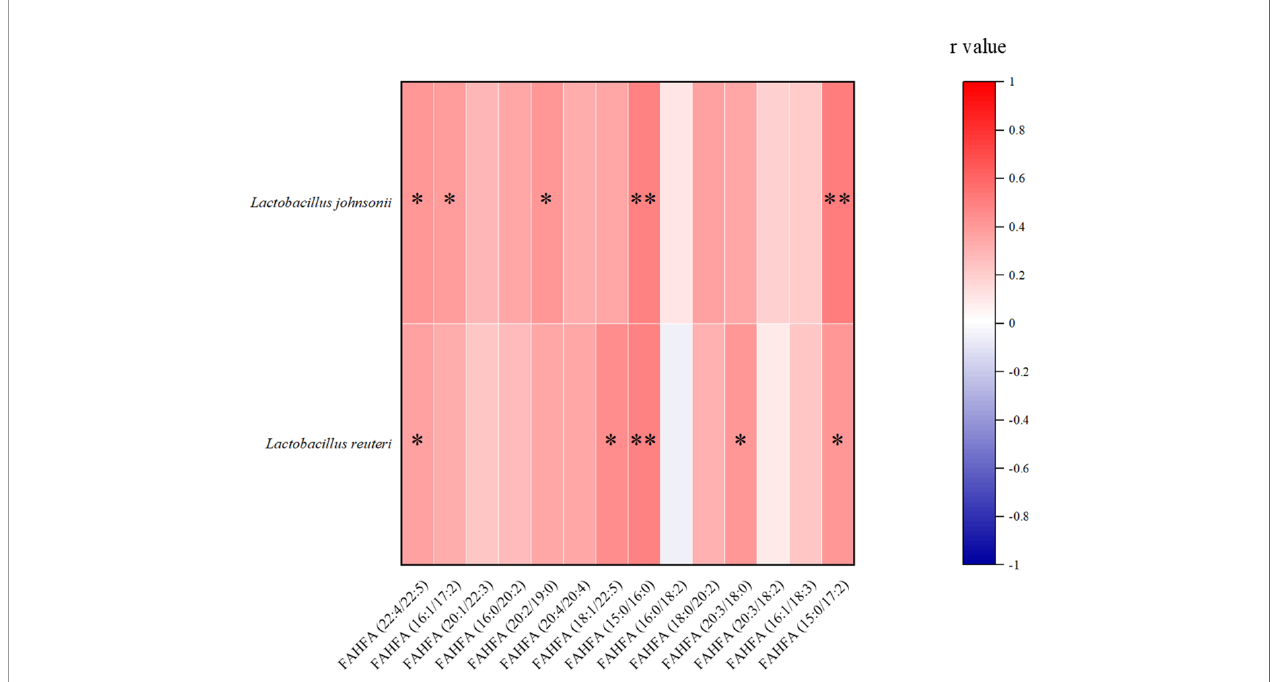
FIGURE 6 | Spearman correlation analysis between FAHFAs levels and Lactobacillus johnsonii and Lactobacillus reuteri. * p< 0.05, ** p<